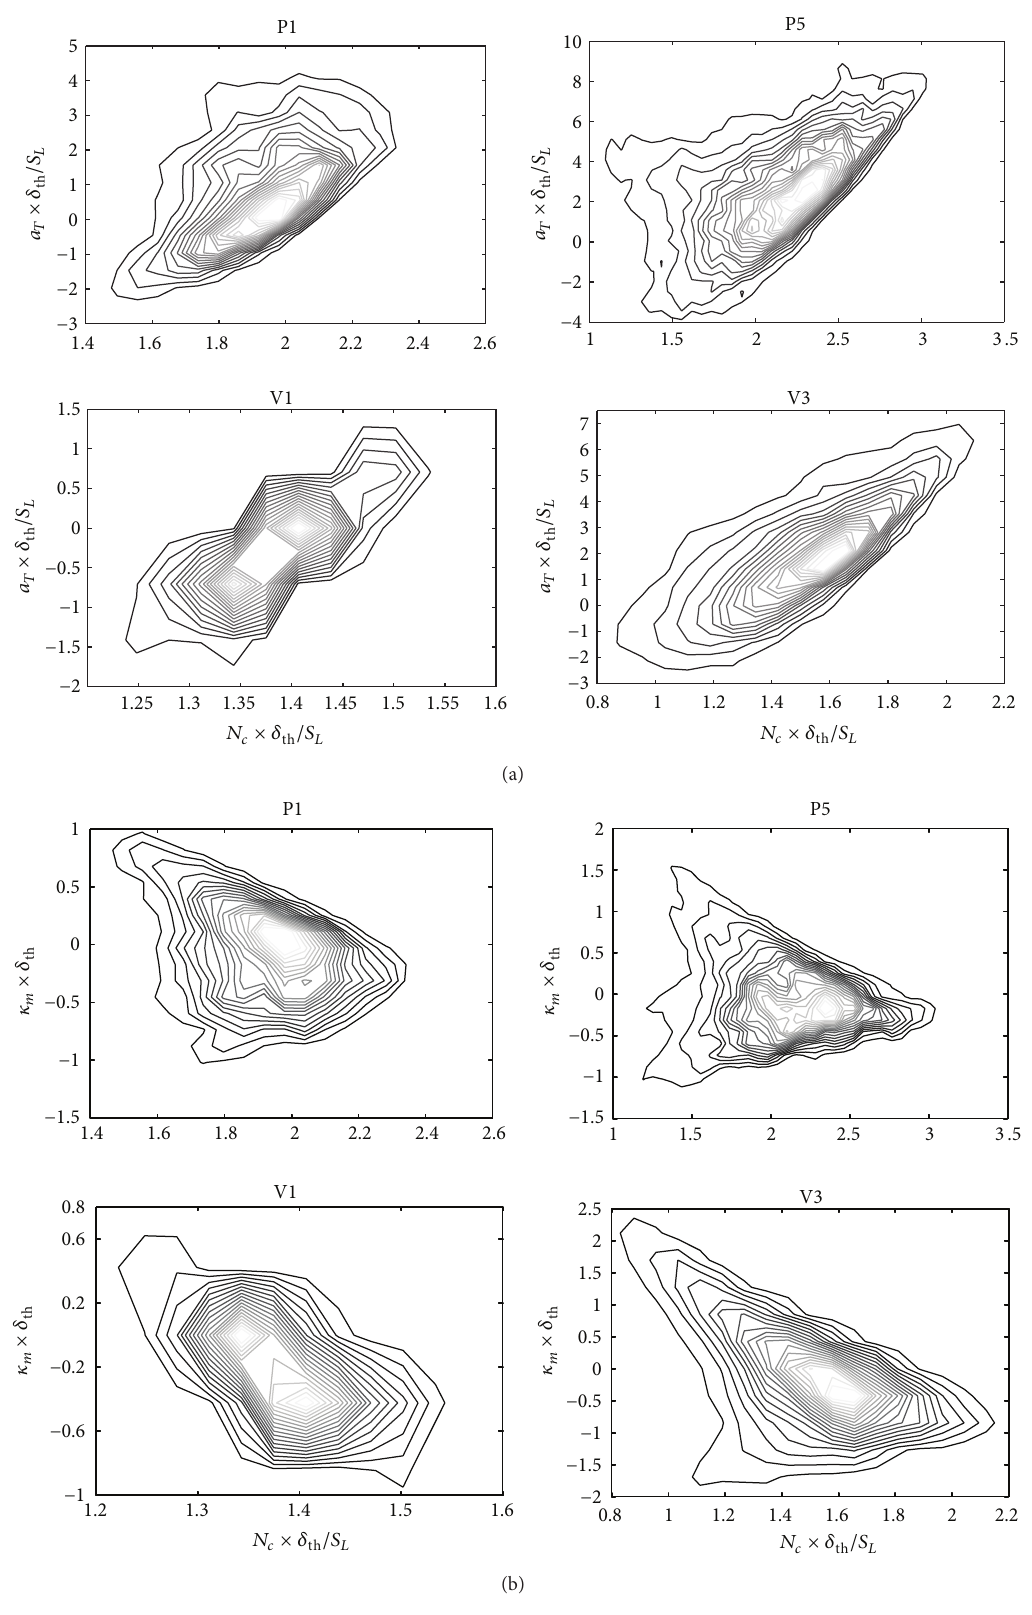
/𝑆 𝐿 and normalised tangential strain rate th /𝑆 𝐿 and normalised curvature th